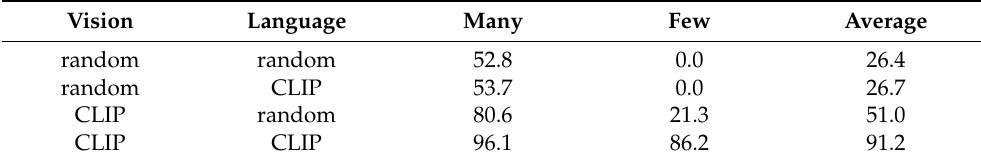
Table 6. Ablations results obtained with pretrained vision-language weights on the clamp